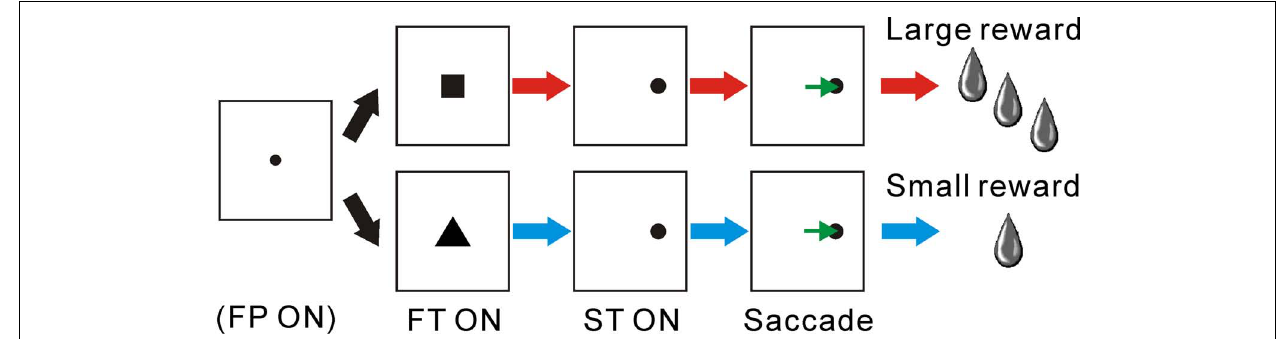
FIGURE 1 | Schematic diagram for the reward-biased visually guided saccade task. The monkeys initially fixated on the central visual stimulus, then made a saccade to the peripheral target, and finally received a juice reward. During the fixation period before the visually guided saccade and